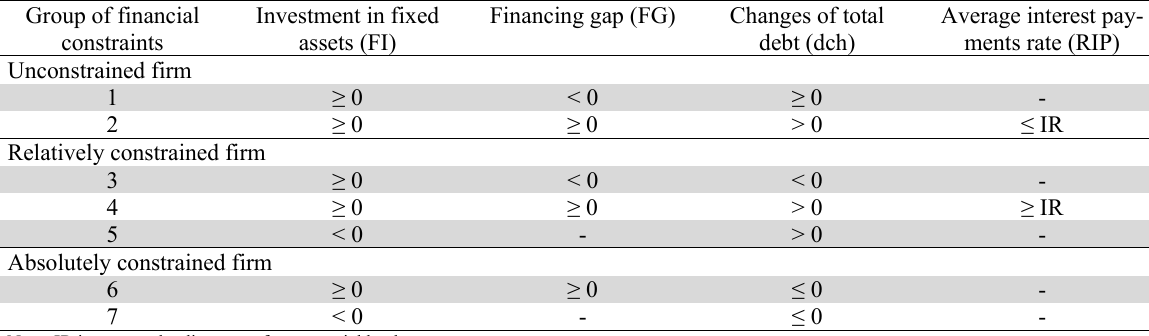
The classification of financial constraints